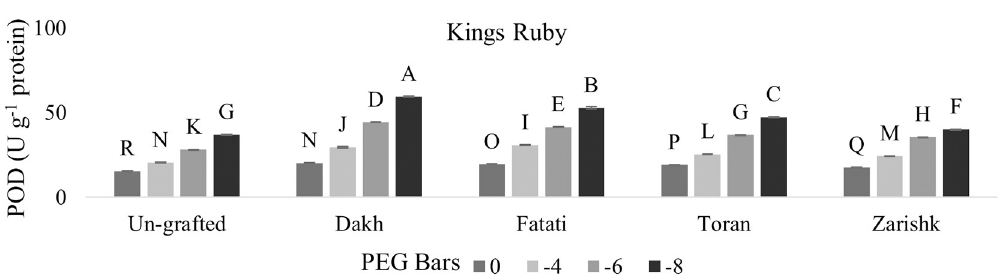
Fig 15. Ascorbate peroxidase (POD) enzymatic activity of un-grafted and grafted Kings Ruby scion variety grafted on different wild grapevines under drought stress condition. Data is represented as mean SD and letters showed significant difference at p < 0.05.